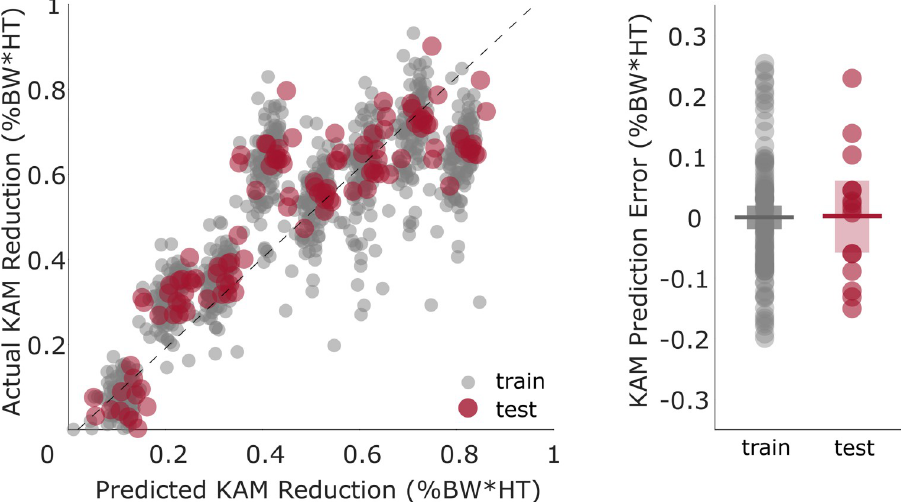
Fig 5. Prediction of KAM reduction using synthetic training data (Calgary Running Injury Clinic dataset). Synthetic toe-in data from 108 subjects were used to train the predictive model, which achieved an MAE of 0.0826 ( ± 0.0628) %BW � HT on the test set of 15 subjects. The line of best fit (dashed line) has an R 2 of 0.87. The signed errors (the difference between actual and predicted KAM reduction) of the training and test sets were similarly distributed around